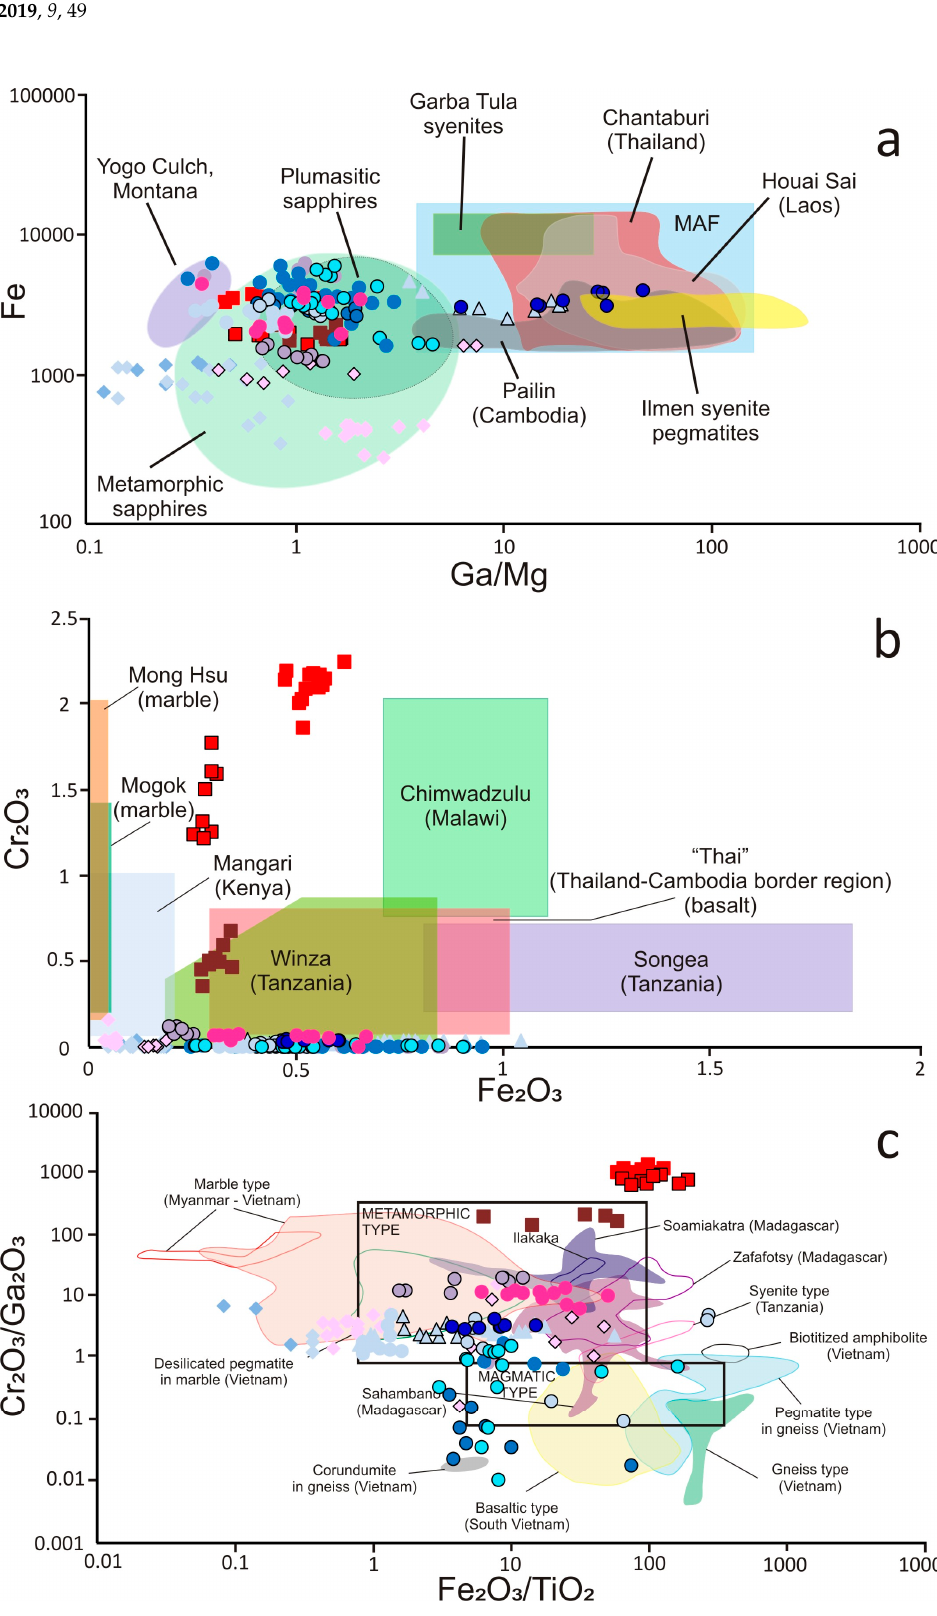
Figure 12. Greek corundum LA-ICP-MS analyses plotted on a ( a ) Fe versus Ga/Mg discrimination diagram (after Peucat et al. [16], Zwaan et al. [89]); ( b ) Cr 2 O 3 versus Fe 2 O 3 diagram demonstrating the fields of different African deposits (modified after Schwarz et al. [90]); ( c ) Cr 2 O 3 /Ga 2 O 3 versus Fe 2 O 3 /TiO 2 plot demonstrating composition of diverse corundum deposits (modified after Rakotondrazafy et al. [91], Sutherland et al. [4], Pham Van et al. [92], Simonet et al. [93]. Symbols as in Figure